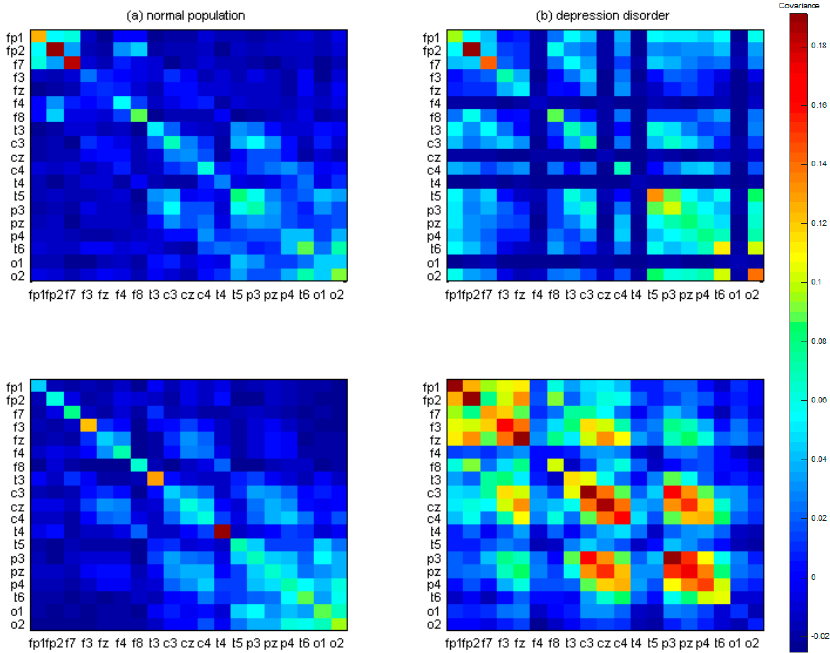
Figure 4. The 19 × 19 covariance matrix images after signal averaging. ( a ) Two randomly selected examples from the control group. ( b ) Two randomly selected examples from the major depressive disorder (MDD) group. Color pixels represent the covariance values.